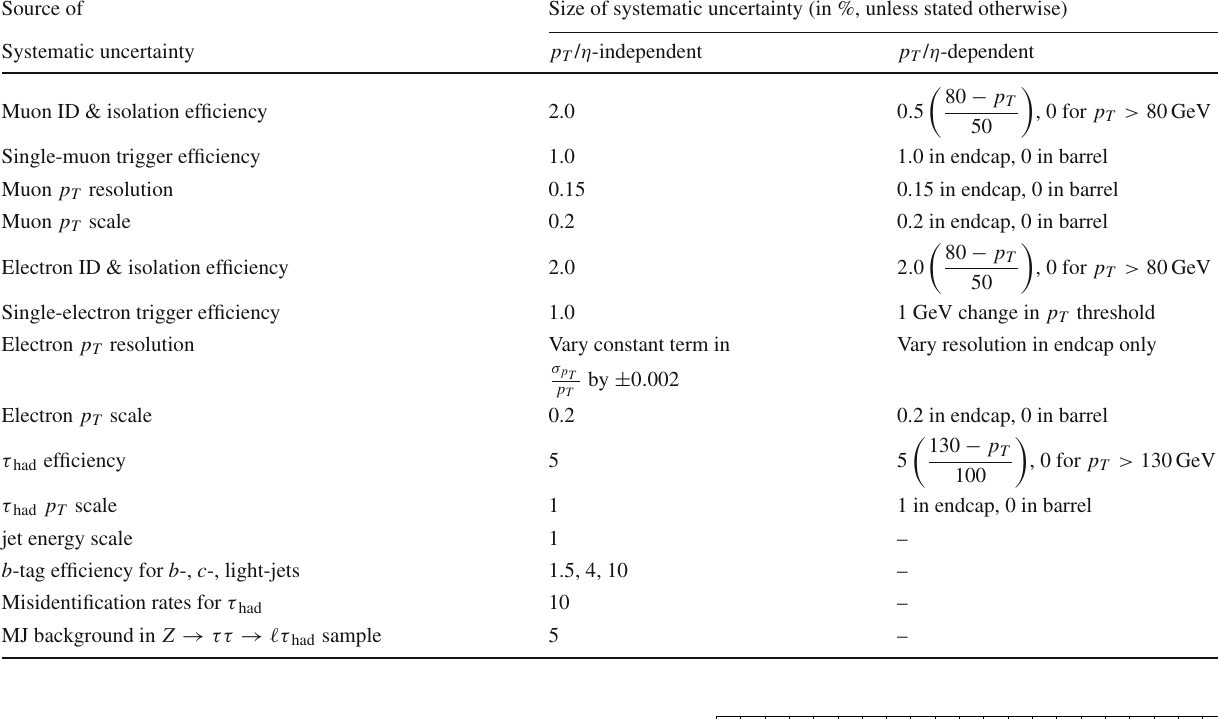
In all expressions p T is given in units of GeV. We define the endcap regionby | η | > 1 . 0.SeetheAppendixforfurtherdetailandjustification